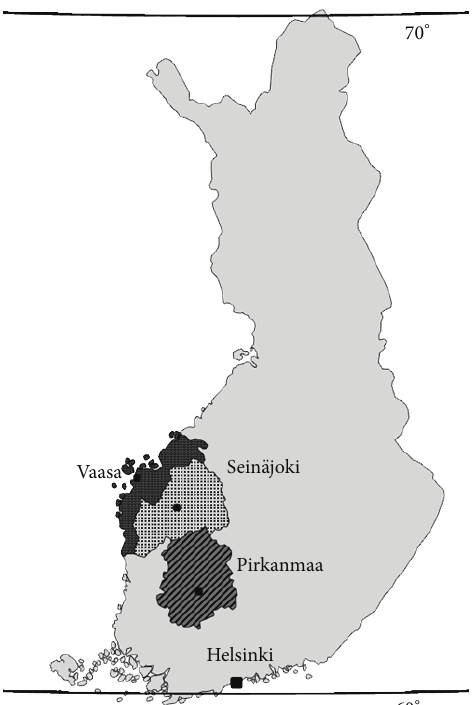
Figure 1: Map of Finland. Finland lies in Scandinavia, North Europe between latitudes 60–70 ∘ N. Gulf of Bothnia in northern mostpart of Baltic Sea limits the west coast. The total population was 5.4 million in 2010. The University Hospital District of Tampere is demarcated, and location of central hospitals and hospital districts in Pirkanmaa (oblique lines), Sein¨ajoki (dots), and Vaasa (dark grey) are pointed in the